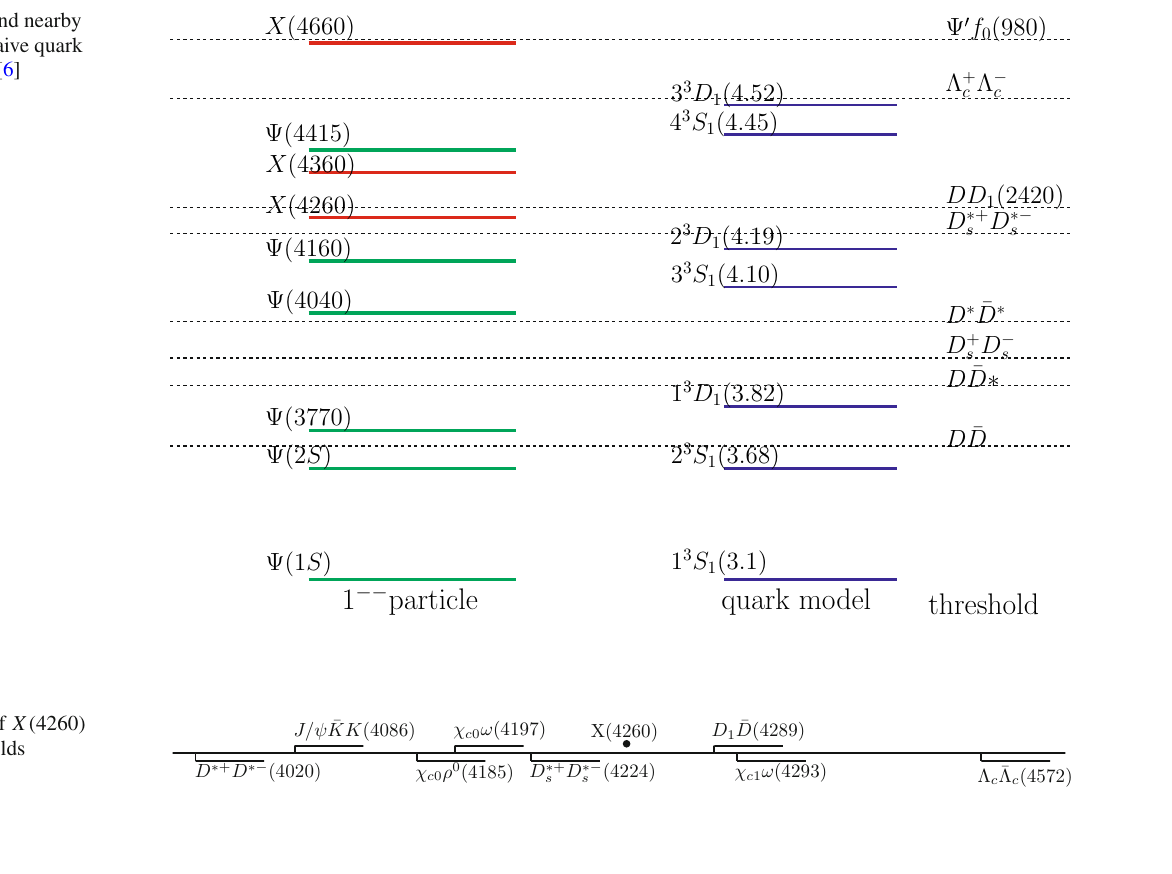
1 −− particle quark model threshold